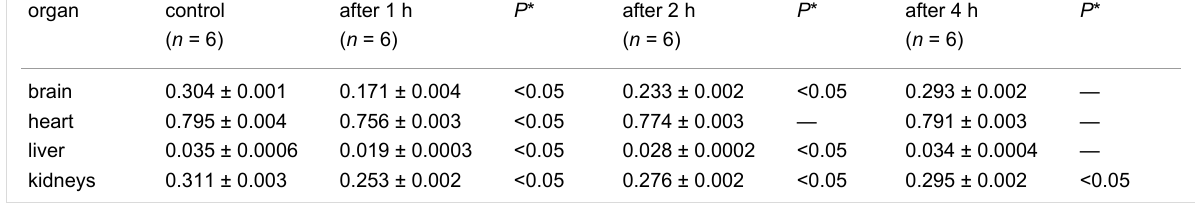
Table 3: Activity of superoxide dismutase normalised to the wet-tissue mass (U/mg) after administration of PEGylated nano-graphene oxide in differ- ent organs after different periods of time (mean ± standard deviation). organ